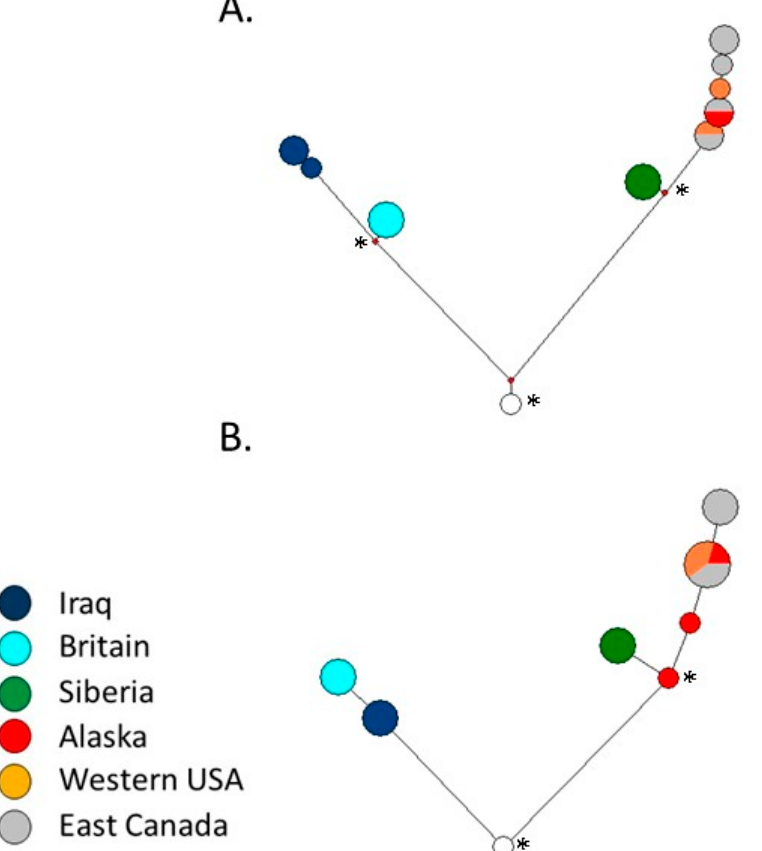
Figure 4. Median joining networks utilizing ( A ) 31 Y chromosome SNPs in 17 red foxes or ( B ) a subset of 13 assayed Y chromosome SNPs in 19 red foxes (including two additional Alaskan red foxes); the ancestral node (or root, white circle) in each network corresponded to the haplotype common to all coyotes, gray foxes and the island fox. Red dots in ( A ) represent inferred nodes. ( A , B ) Nodes (observed or inferred) used for ageing haplogroups through rho statistics are indicated with an asterisk. Node sizes are proportional to the number of foxes and branch lengths are proportional to the number of mutations.